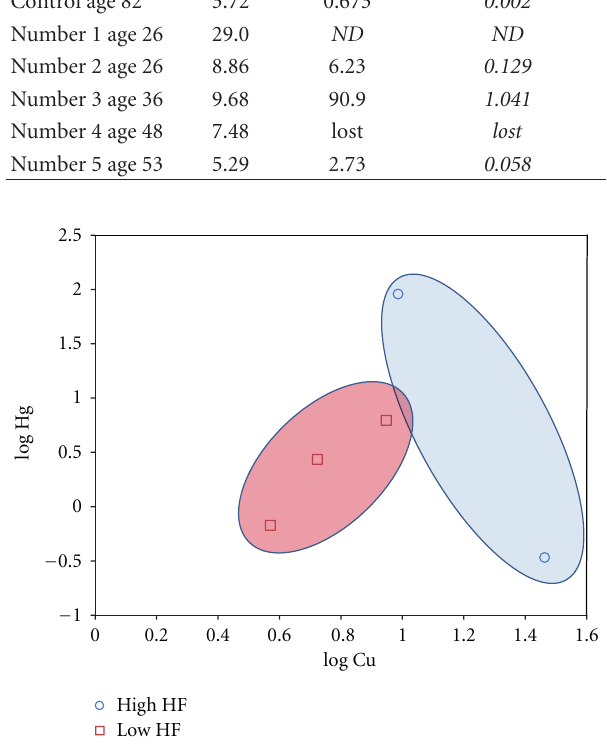
Figure 1: The high-frequency/low-frequency power bands of the hydrogen isotope ratios along the hair reflect the control by the autonomic nervous system (ANS) of biologic rhythms. Hg and Cu both influence the power bands. Note that Cu is associated with low-HF power of the spectra of the hydrogen isotope ratios along the length of the